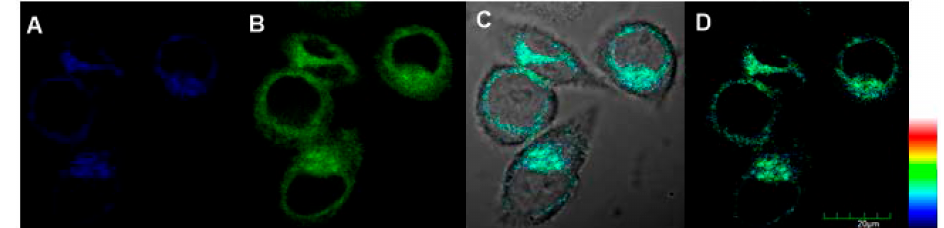
Figure 6. Two-photon fluorescent imaging of HeLa cells treated with probe 1 (10 µ M): ( A ) from blue channel; ( B ) from green channel; ( C ) overlay imaging of ( A , B ); and ( D ) pseudo color imaging of ( A , B ), λ TPEx =720 nm, Blue channel λ Em : 410–460 nm and green channel λ Em : 470–530 nm, Scale bar: 20 μ m.